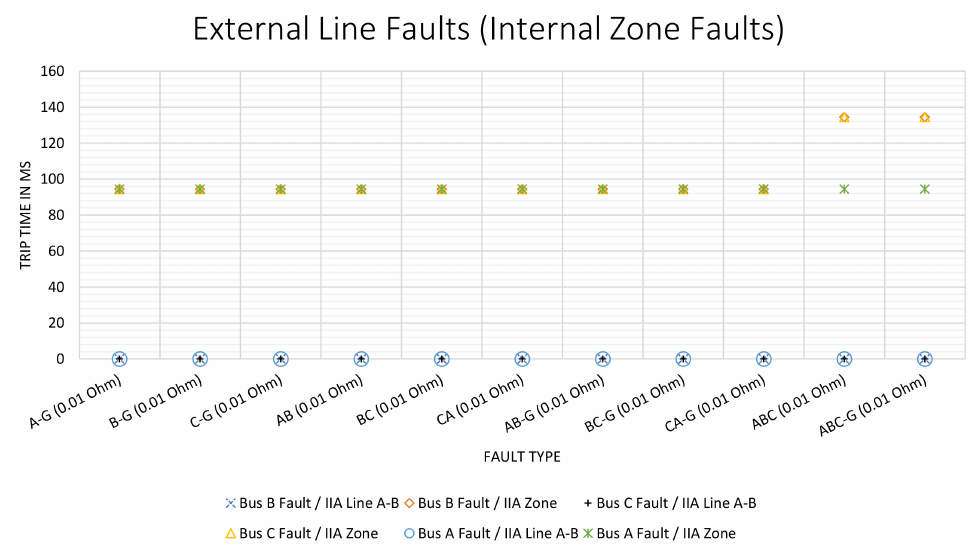
Figure 12. Results for external line faults test, Side B without